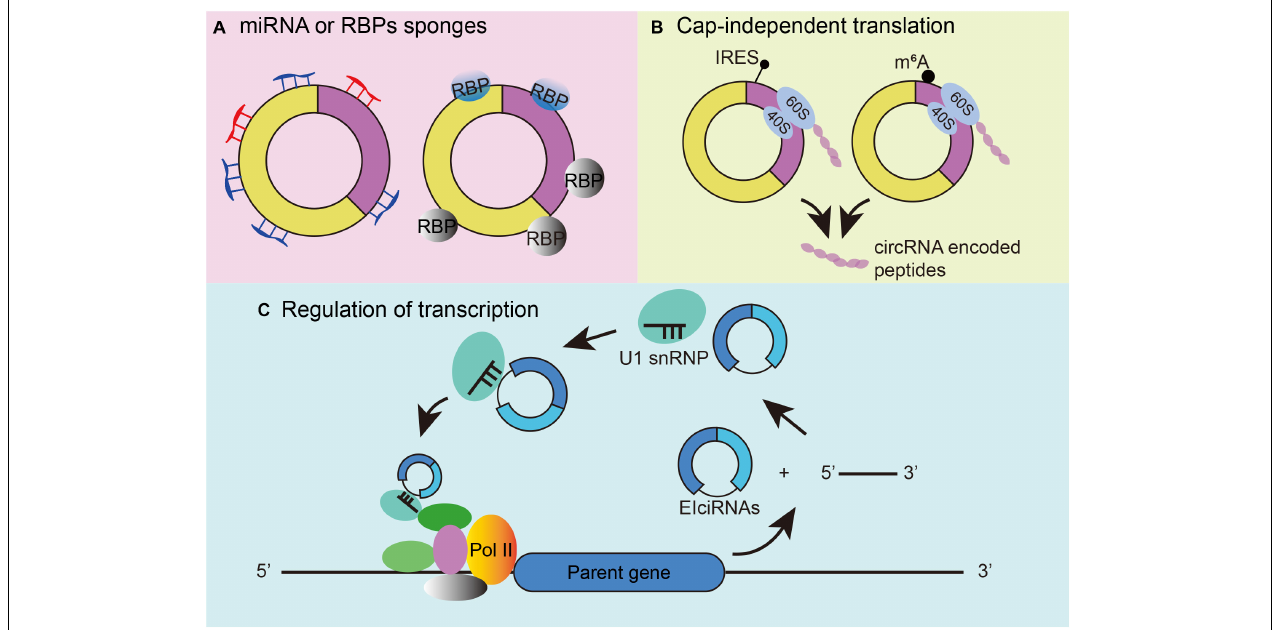
FIGURE 2 | Mechanisms of circRNA functions. (A) CircRNAs can function as microRNA and RBP sponges. (B) CircRNA cap-independent translation mechanism: IRES-driven circRNA translation (left) and m6A-driven circRNA translation (right). (C) Regulation of transcription initiation by